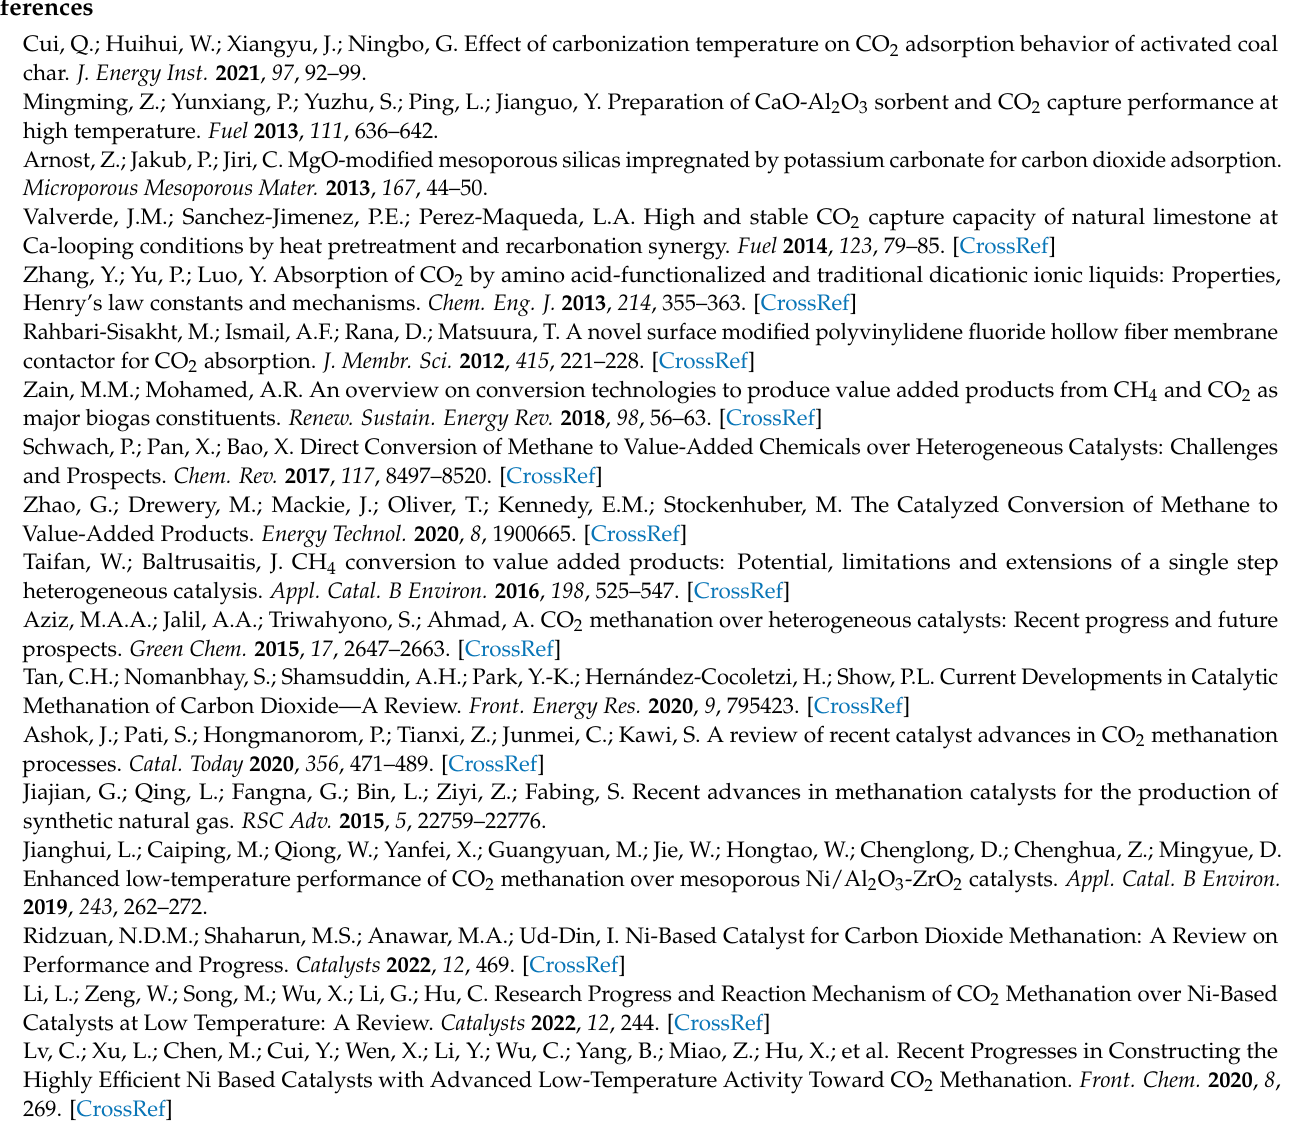
Figure S5. SEM and mapping images of 15wt%Ni/Z_5D_9h and